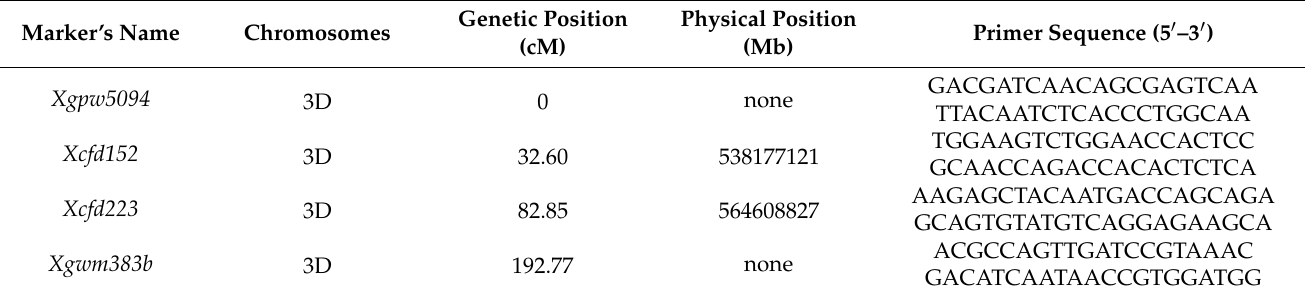
Table 2. Primer sequences of the simple sequence repeats (SSR) assays developed in this